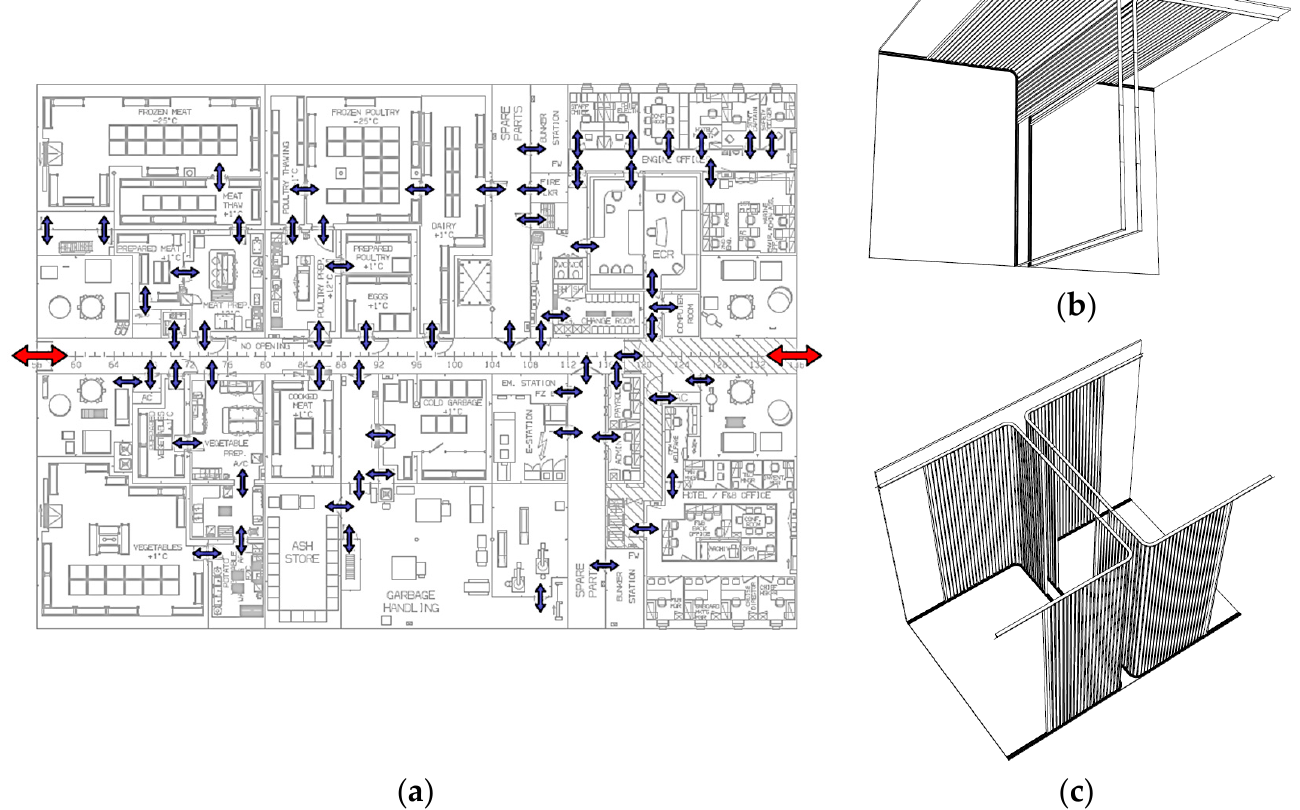
Figure 5. AREST A2 system; ( a ) main (red) and minor (blue) flooding path on a cruise ship deck zone. ( b ) Vertically deployable shutters. ( c ) Horizontally deployable shutters.